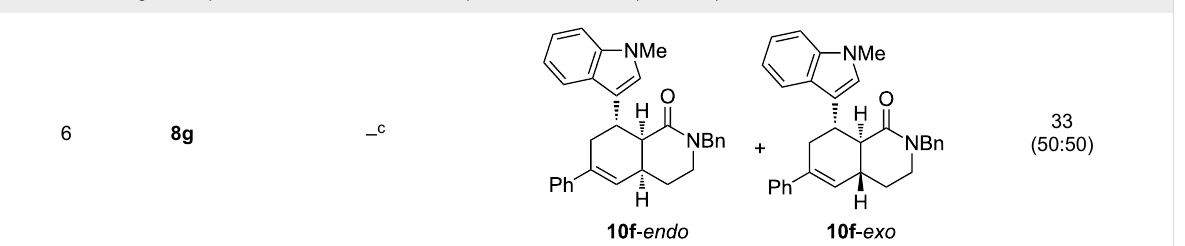
Table 3: Extending the scope of the tandem CEYM–IMDAR protocol to amides 8 . (continued)